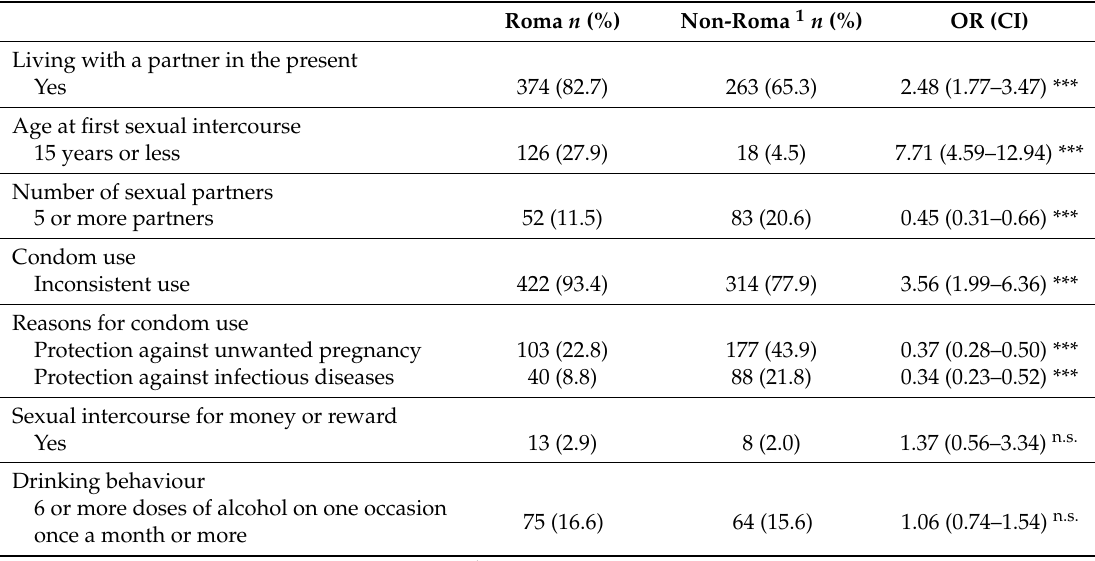
Table 2. Sexual and drinking behaviour of the population living in Roma settlements and the non-Roma population in eastern Slovakia (logistic regression model adjusted for age, odds ratios and 95% confidence intervals).